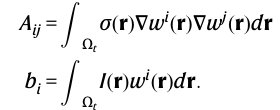
Fig. 6 | Model geometry. a Surface geometry of muscles, bones, subcutaneous tissue, skin and electrodes used for arm modelling (taken from BodyParts3D, The DatabaseCenterforLifeScience(http://lifesciencedb.jp/bp3d/)). b Cross-sectionof the volume mesh generated from the arm surfaces. c Uniformly distributed fi bres